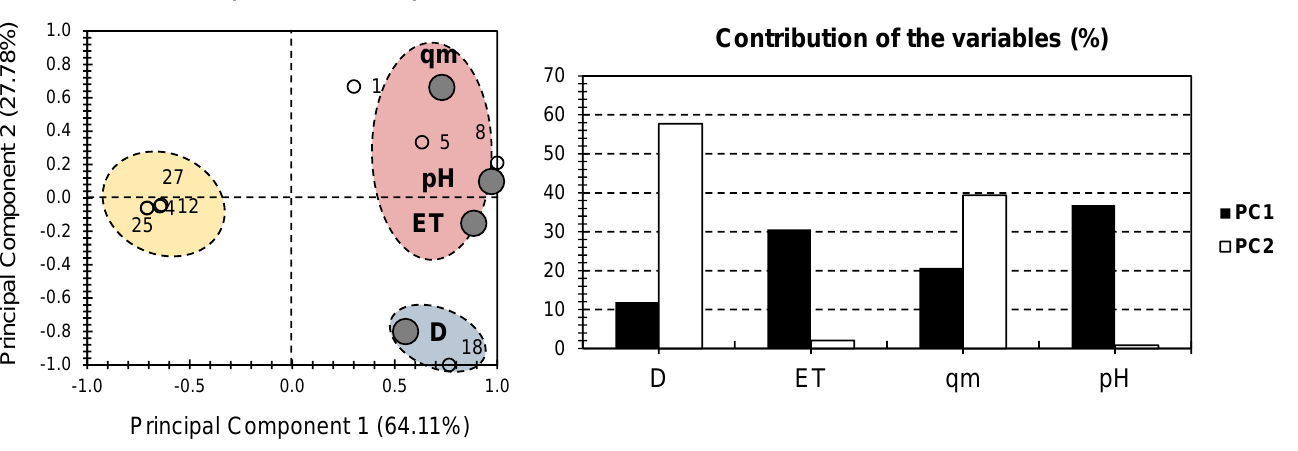
Figure 4. PCA for all datasets. Small bullets represent the 15 investigated hydrogels containing MONPs (yellow cluster components of Figure 2). Large gray bullets represent different physical and chemical properties, with the exclusion of metallic oxide nanoparticles (MONP%). Individuals were divided into three clusters; the red cluster contained samples 1, 5, and 8, and had a high positive correlation with qm, pH, and ET. The blue cluster contained only hydrogel sample 18 and demonstrated a strong positive correlation with D. The yellow cluster contained samples 4, 12, 25, and 27, and it was located on the opposite side of the different factors (along the negative side of PC2). Given the high variance, it is safe to assume that the composite hydrogel CMSt/PVA/Fe 3 O 4 should be used with high adsorbent doses. For CTS@Fe 3 O 4 , PAAm/TiO 2 , and PEGDMA-rGO/Fe 3 O 4 @cellulose, it should be used where high pH, time to reach equilibrium, and adsorption capacity were imple- mented.